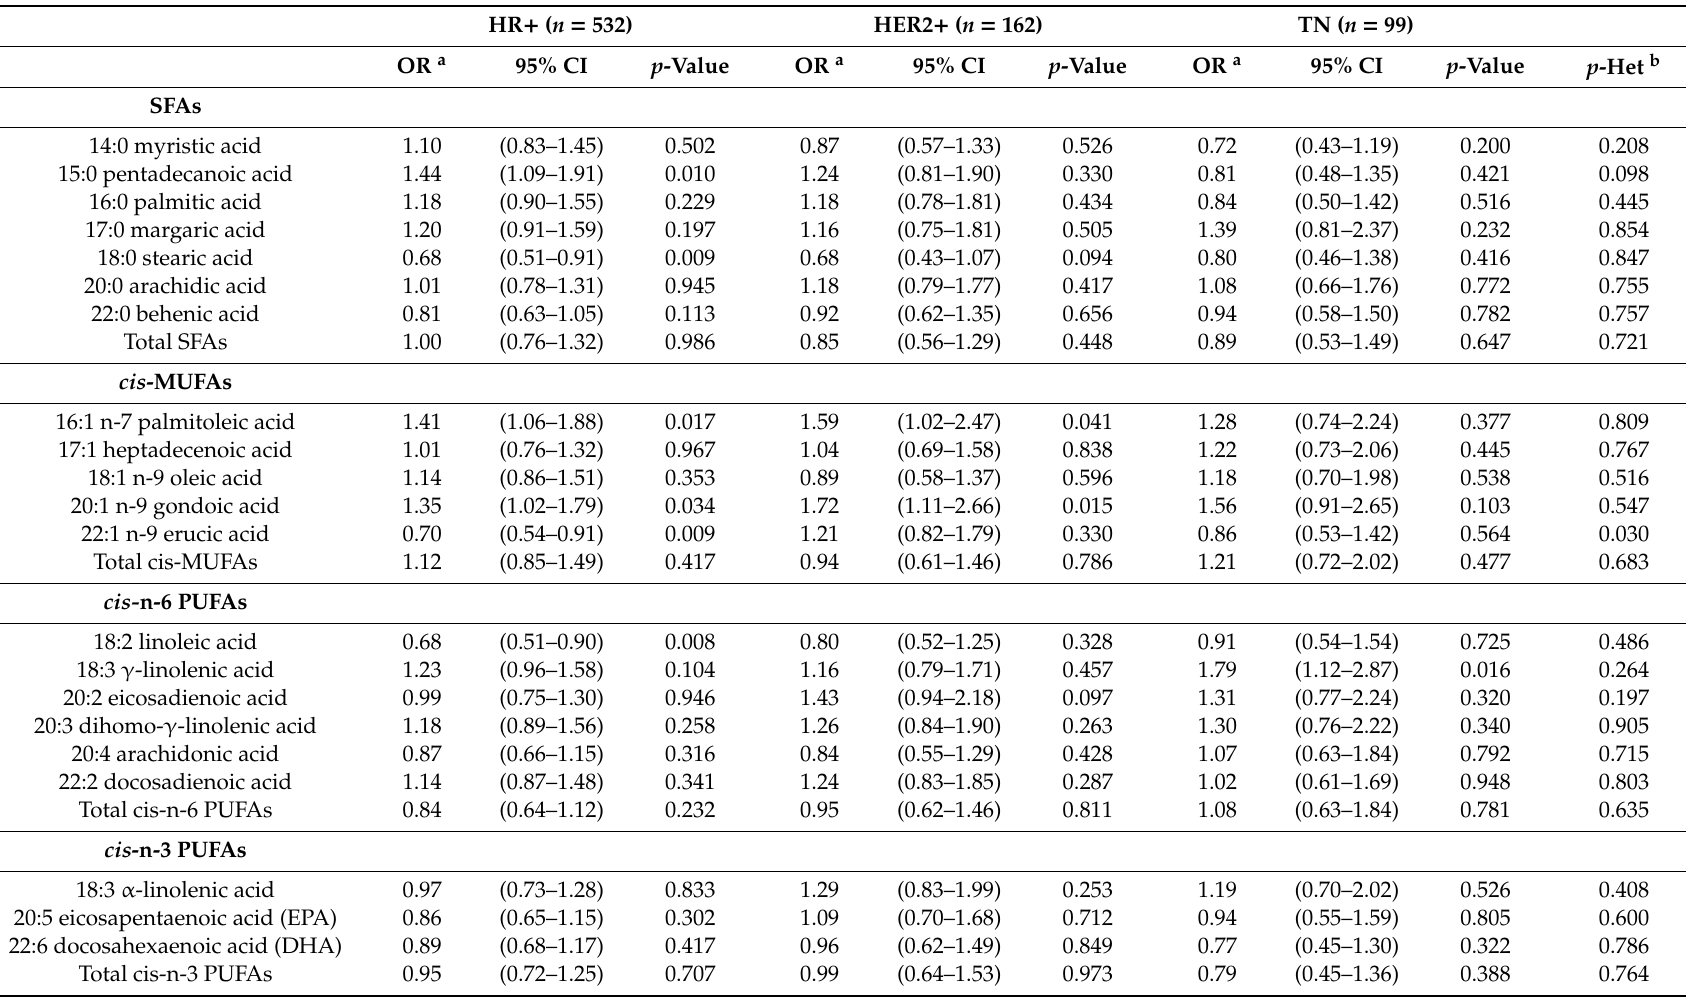
Table 4. Breast cancer risk for the third tertile compared with the first tertile of each serum phospholipid fatty acid by pathological